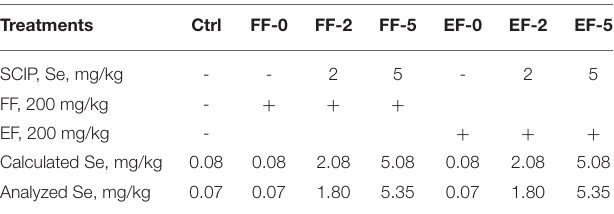
TABLE 1 | Experimental design.